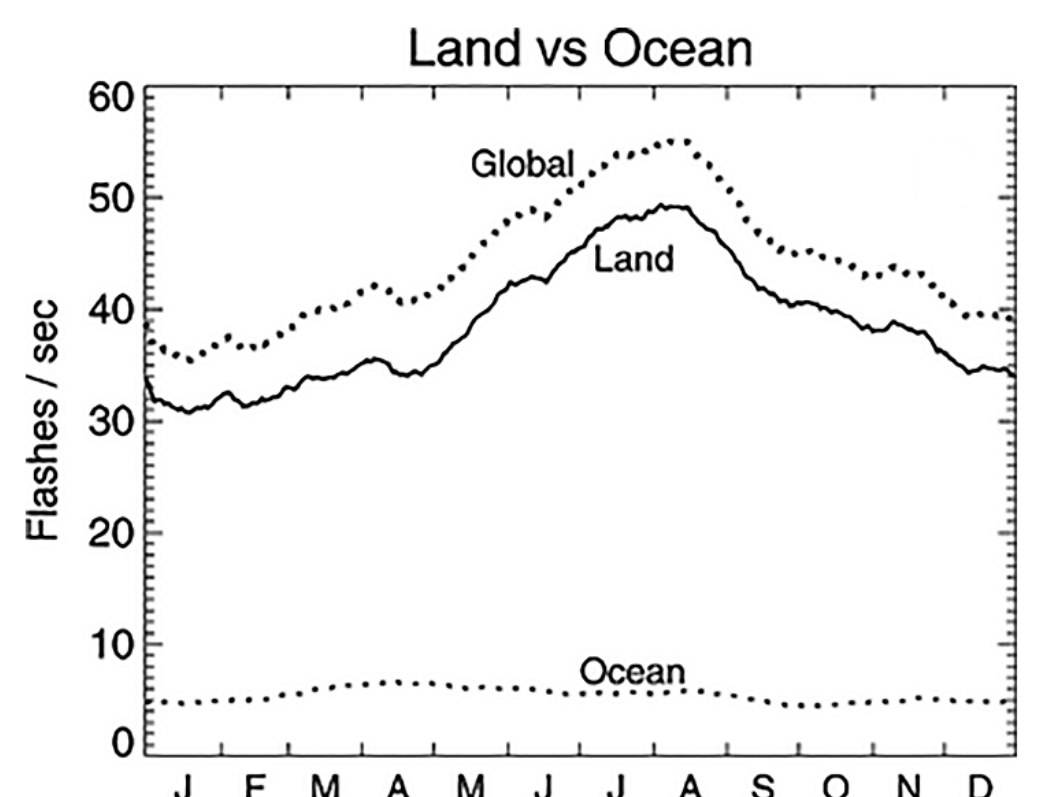
Figure 3. Number of lightning strokes accumulated for the years 2008–2017, presented as strokes per year per square kilometer on a 0.1° × 0.1° global grid. Data are from the WWLL Network.